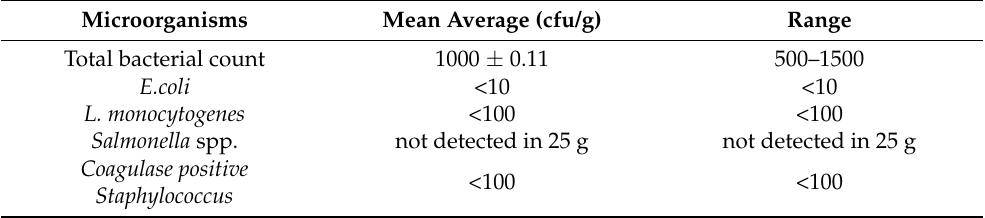
Table 1. Microbiological profile (cfu/g meat) of spiny-cheek crayfish.